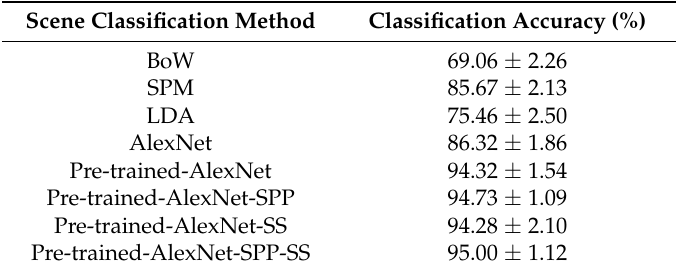
Table 3. Scene classification results for the WHU-RS